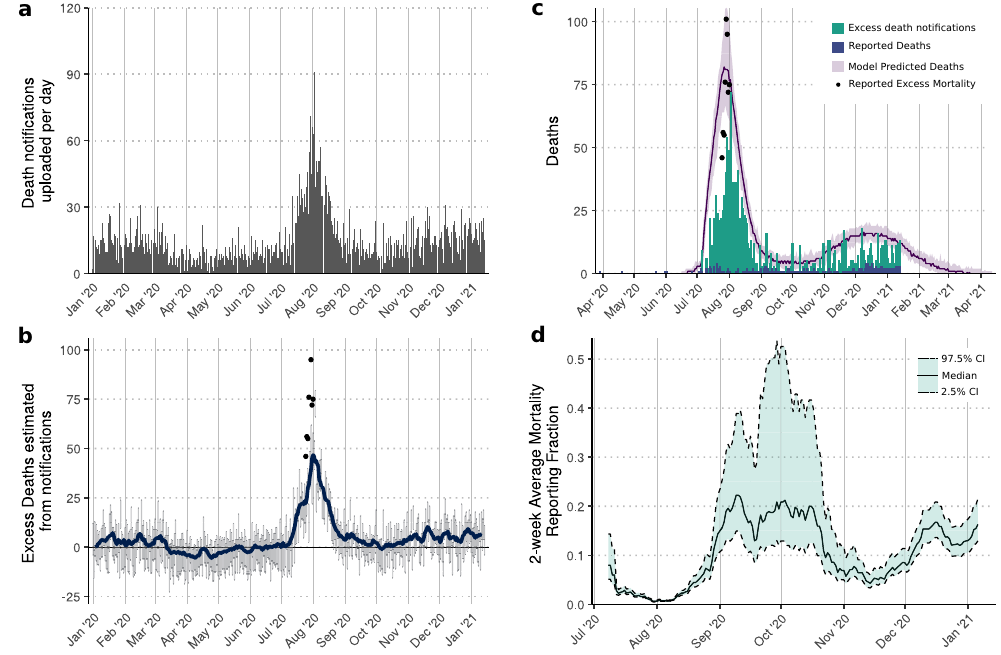
Fig. 5 Characterising the dynamics of the second wave in Damascus. In ( a ) we show the number of obituary noti fi cations uploaded daily to the community maintained ‘ Damascus Mortality ’ Facebook page. In ( b ), the daily inferred excess death noti fi cations are shown, with error bars showing the 95% CI and the blue line indicating the weekly average excess deaths ( n = 100). In ( c ) model fi ts (purple, median and 95% CI in shaded region) to the noti fi cation excess death data (vertical green bars) are shown under the assumption that 40% of total COVID-19 deaths are ascertained by the noti fi cation excess deaths, which correctly captures the excess mortality reported by the Syrian government between 25 July and 1 August (black dots). The model- predicted COVID-19 deaths in ( c ) are signi fi cantly greater than the of fi cial reported COVID-19 deaths (blue bars), with the reporting fraction (of fi cial deaths divided by model-predicted deaths) since July shown in ( d ). In ( d ) the 2-week rolling average reporting fraction is shown, with the 95% CI shown between the dashed